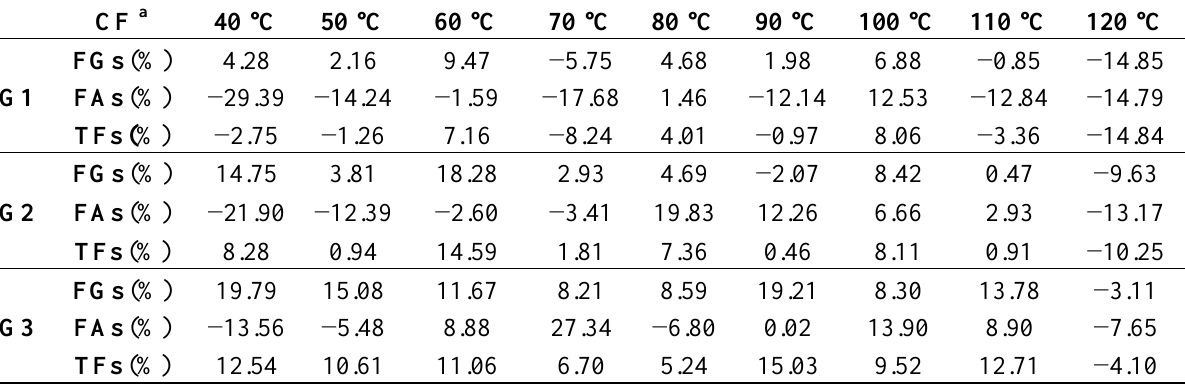
Table 2. The rate of increase of flavonoid contents when the moisture reached the